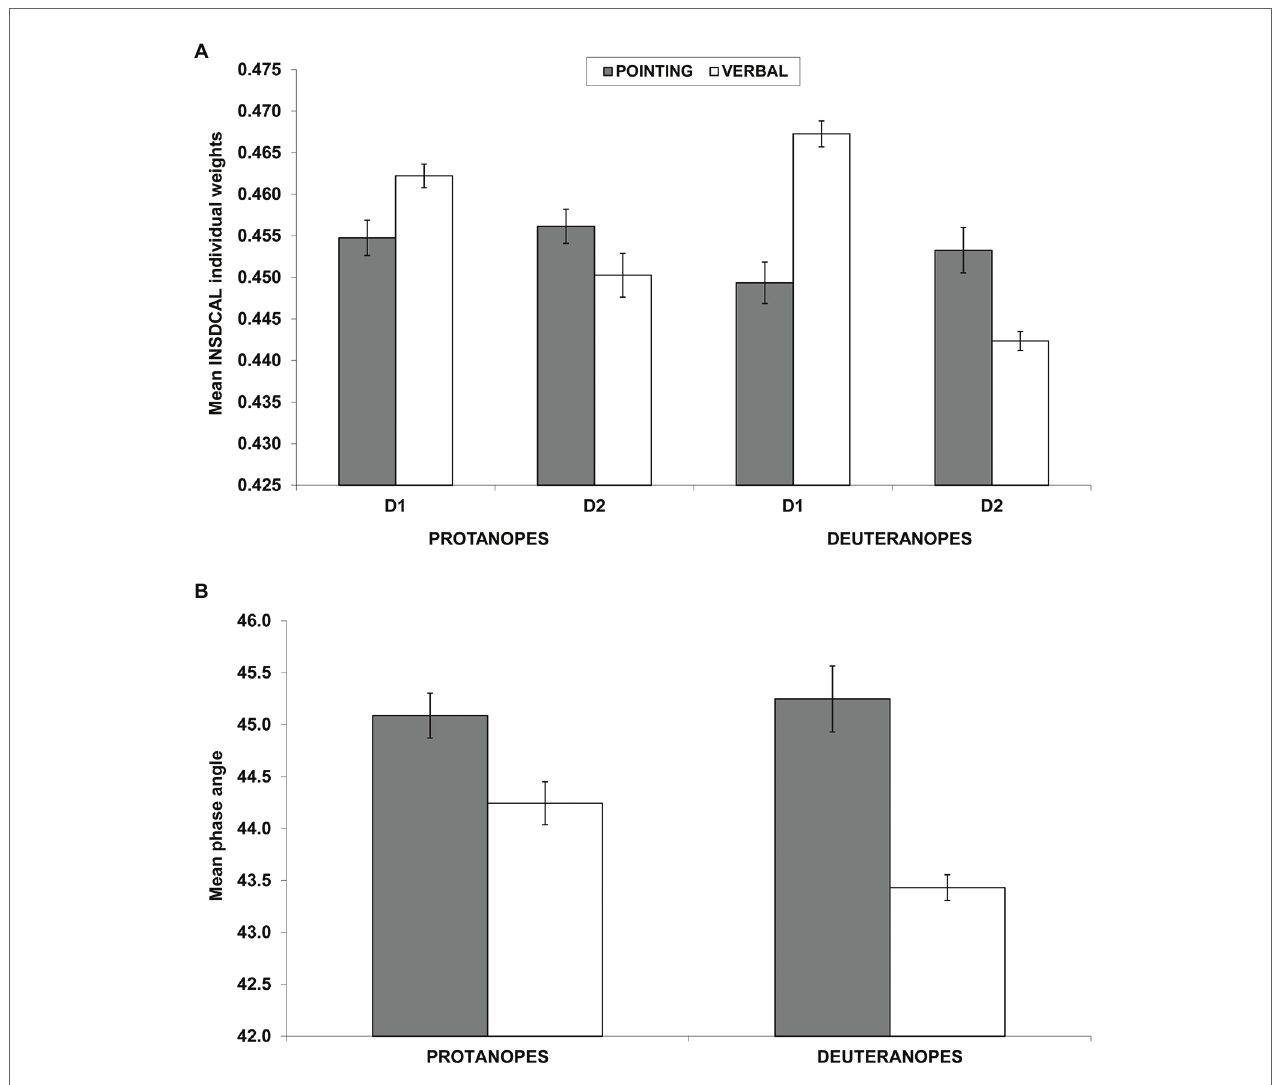
FIGURE 4 | Individual dimensional weights obtained in the INDSCAL analysis (A) and phase angles of the corresponding vectors (B) . (A) Mean (±SEM) weights obtained in the INDSCAL analysis for protanopes and deuteranopes in the pointing task (dark gray bars) and the verbal task (white bars) for D1 (chromatic dimension) and D2 (achromatic dimension). (B) Mean (±SEM) phase angles of the weighting vectors obtained in the INDSCAL analysis for protanopes and deuteranopes. Lower phase angles indicate a relative over-weighting of D1 (chromatic dimension) in relation to D2 (achromatic dimension). Note that y -axis has been truncated for clarity purposes in both